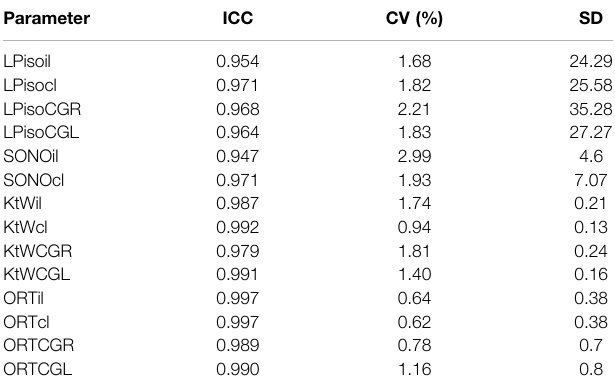
TABLE2| Reliabilityforthepre-testvalues.ICC=intraclasscorrelationcoef fi cient, CV = coef fi cient of variance, SD = Standard deviation. Parameter